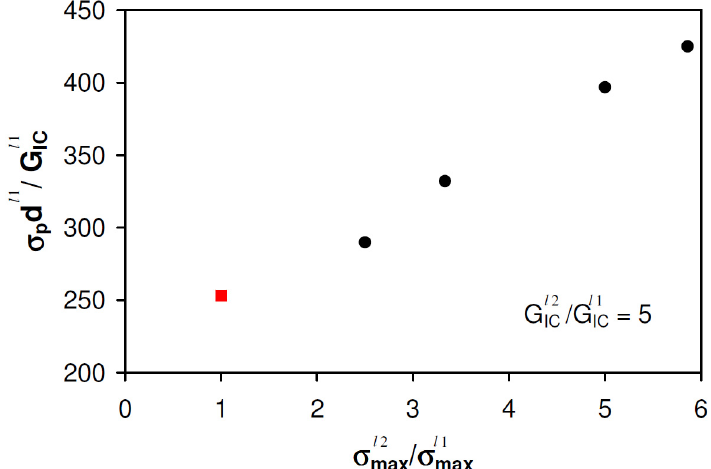
Figure 5. Dimensionless tensile strength vs. CZM peak stress ratio between levels 2 and 1.